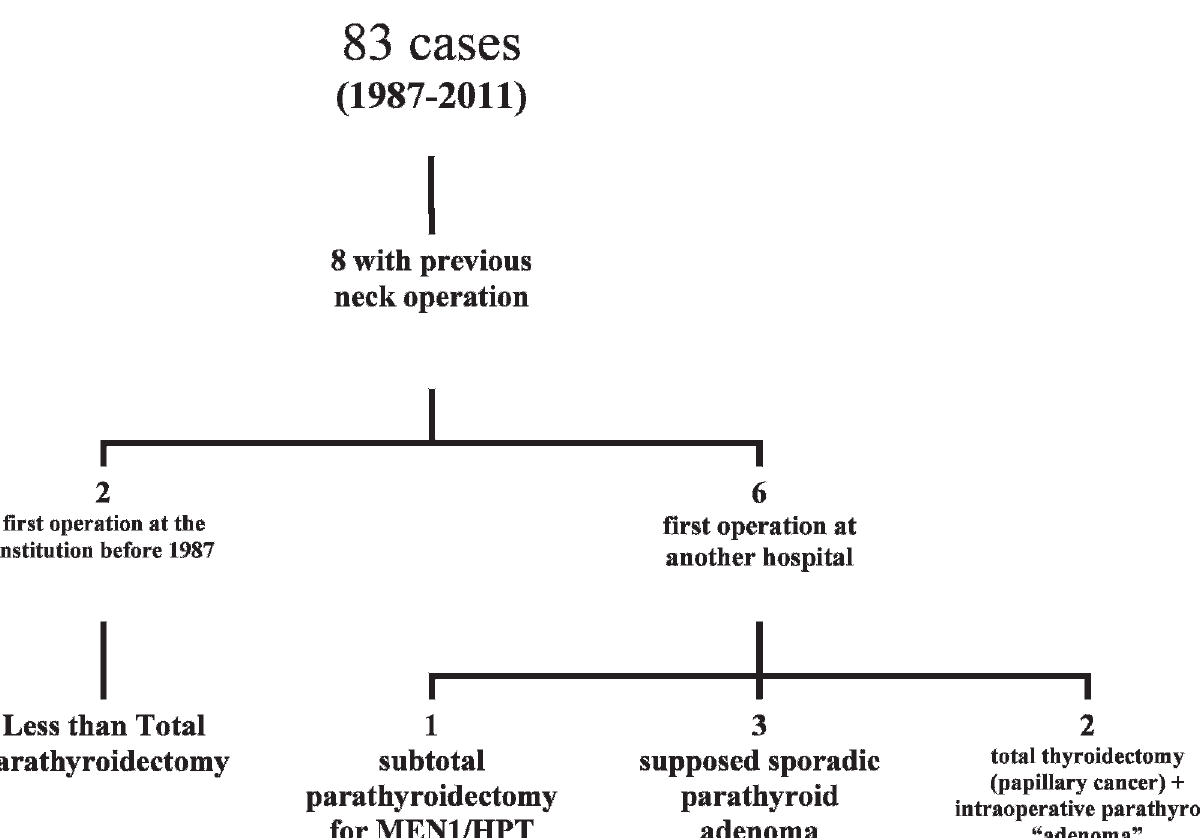
Figure 4 - Distribution of patients with hyperparathyroidism/multiple endocrine neoplasia type 1 who had had a previous